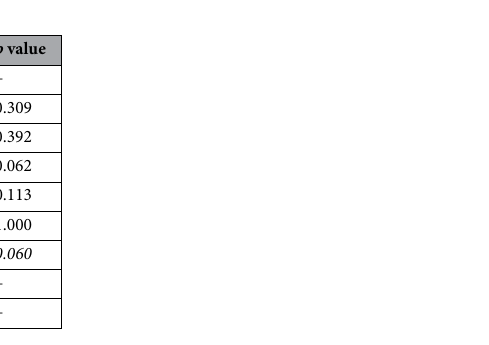
Table 3. Physical characteristics of participants. Data are shown as means ± SD. BMI body mass index, RFS rear foot strikers, FFS forefoot strikers. Age, body height, body mass, BMI, and fractions of leg dominance and foot strike pattern were not significantly different between runners and untrained